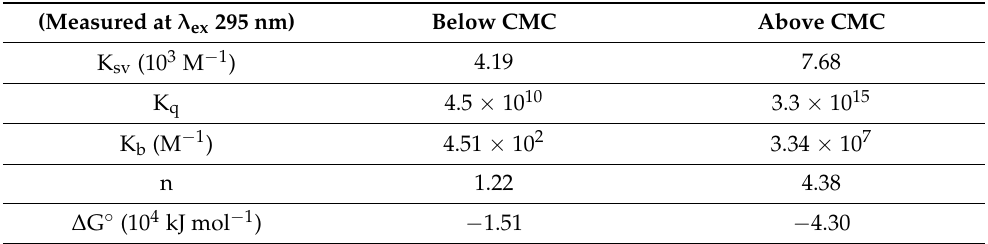
Figure 7. Stern–Volmer plot of interaction of SDS in CAD-ethanol system at 298.15 K above CMC. Table 2. Stern–Volmer quenching constants ( K sv ), quenching rate constant ( K q ), binding constants ( K b ), number of binding sites ( n ), and Gibbs free energy ( ∆ G ◦ ) for the interaction of cinnamaldehyde (CAD) in SDS-ethanol media at 298.15 K